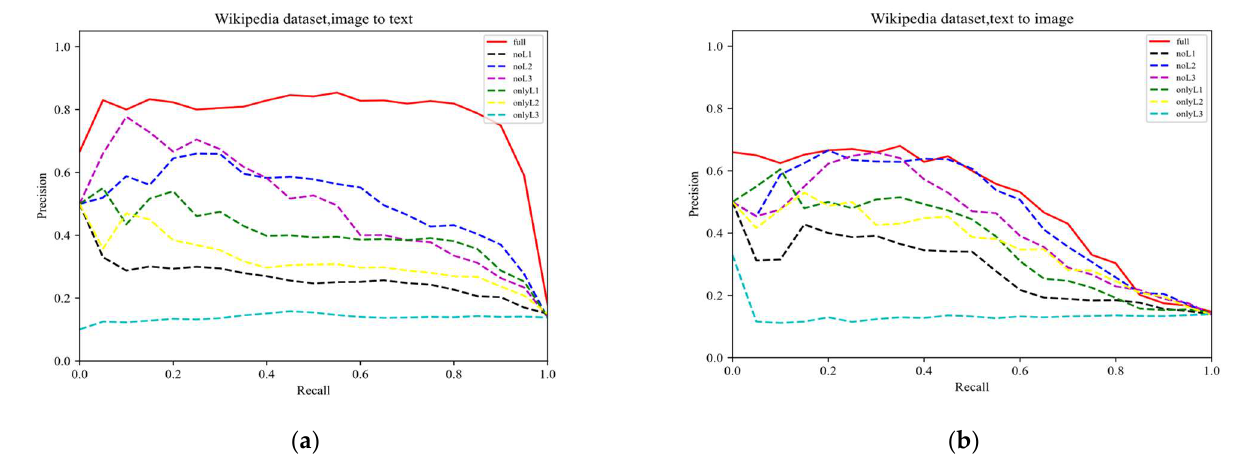
Figure 11. The PR curves of cross-modal retrieval performance on the Wikipedia dataset. ( a ) The image to text task on the Wikipedia dataset. ( b ) The text to image task on the Wikipedia dataset.